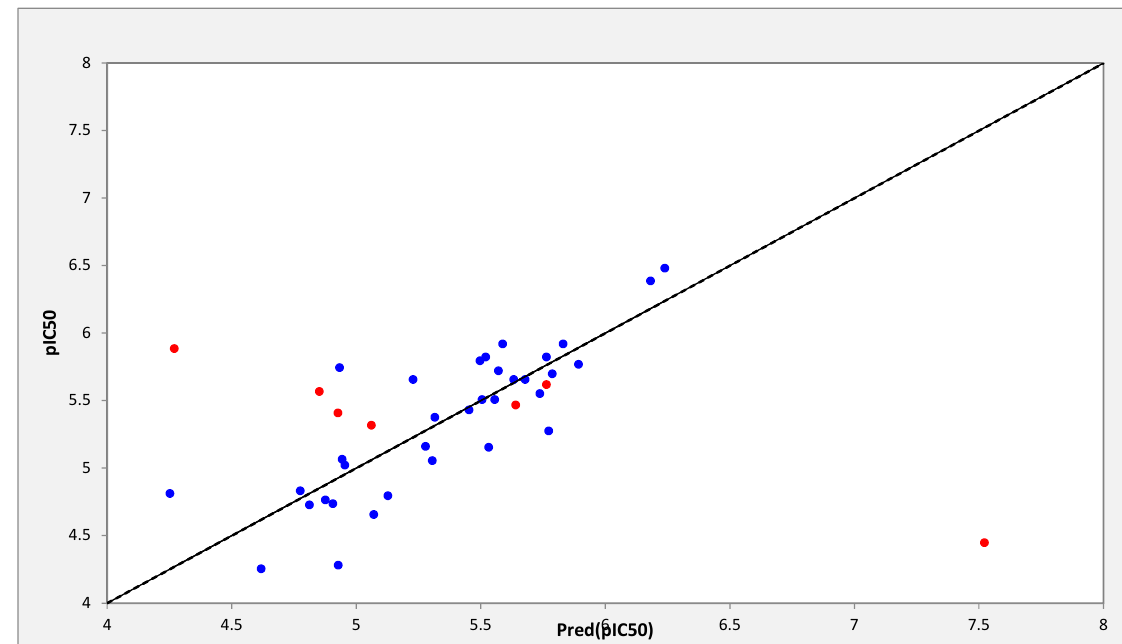
Figure 1. Representation of observed and predicted activities values (pIC50). Table 2. Experimental and predicted activities (pIC 50 ) and residual values, according to MLR model.